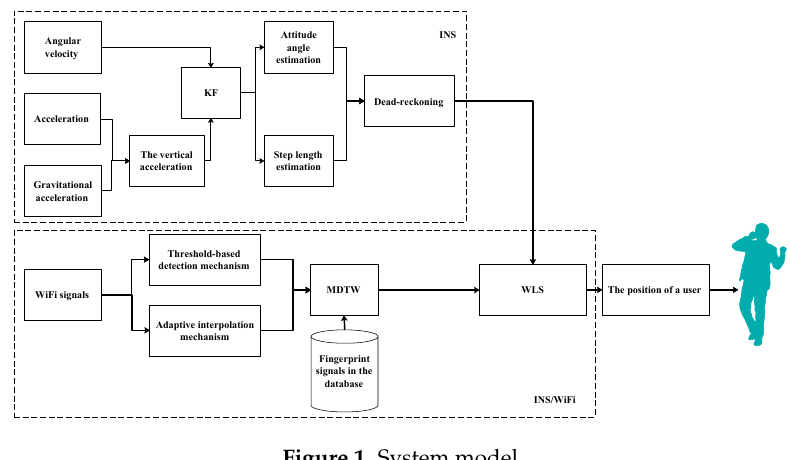
Figure 1. System